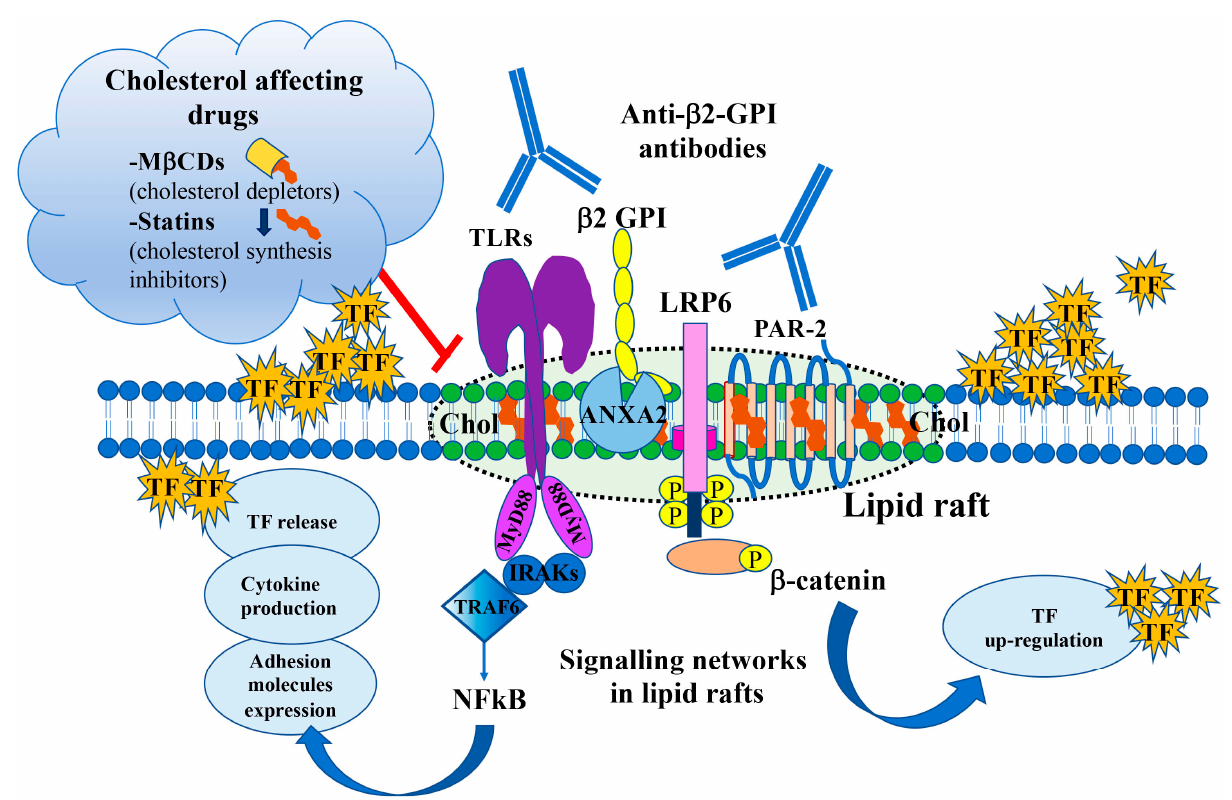
Figure 2. Signaling pathways induced by anti- β 2-GPI antibodies. Scheme depicting the major intra- cellular signaling pathways triggered by anti- β 2-GPI antibodies via TLRs and/or LRP6 through lipid rafts (dotted circle), implicated in the procoagulant endothelial cell phenotype characterized by the expression of TF. Lipid raft-targeted drugs act on cholesterol either as cholesterol depletors (M β CDs) or cholesterol synthesis inhibitors (statins). Annexin A2 (ANXA2); anti- β 2-glycoprotein I (anti- β 2-GPI antibodies); beta-catenin ( β -catenin); cholesterol (Chol); interleukin-1 receptor–associated kinases (IRAKs); LDL receptor related protein 6 (LRP6); methyl- β -cyclodextrin (M β CD); mye- loid differentiation factor 88 (MyD88); nuclear factor-kappa B (NF- κ B); protease activated receptor- 2 (PAR-2); tissue factor (TF); toll-like receptors (TLRs); TNF receptor associated factor 6 (TRAF6).